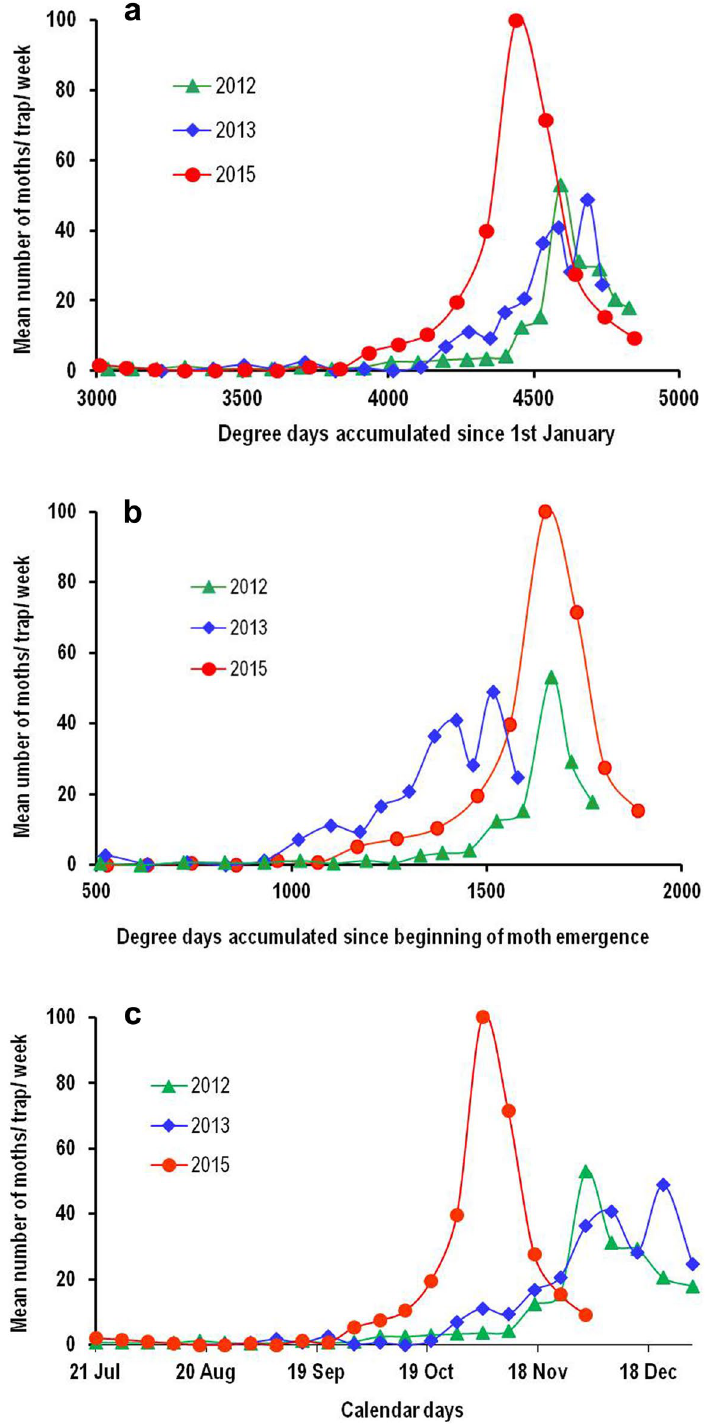
Figure 1. Mean number of pink bollworm moth catches per trap per week recorded from sex pheromone traps installed along the periphery of cotton fields in the experimental farm of ICAR-CICR, Nagpur (India) during 2012–2015. Coincidence or overlapping of moth peaks when plotted on degree-day scale ( a , b ), Non-overlapping of moth peaks when plotted on calendar date scale ( c